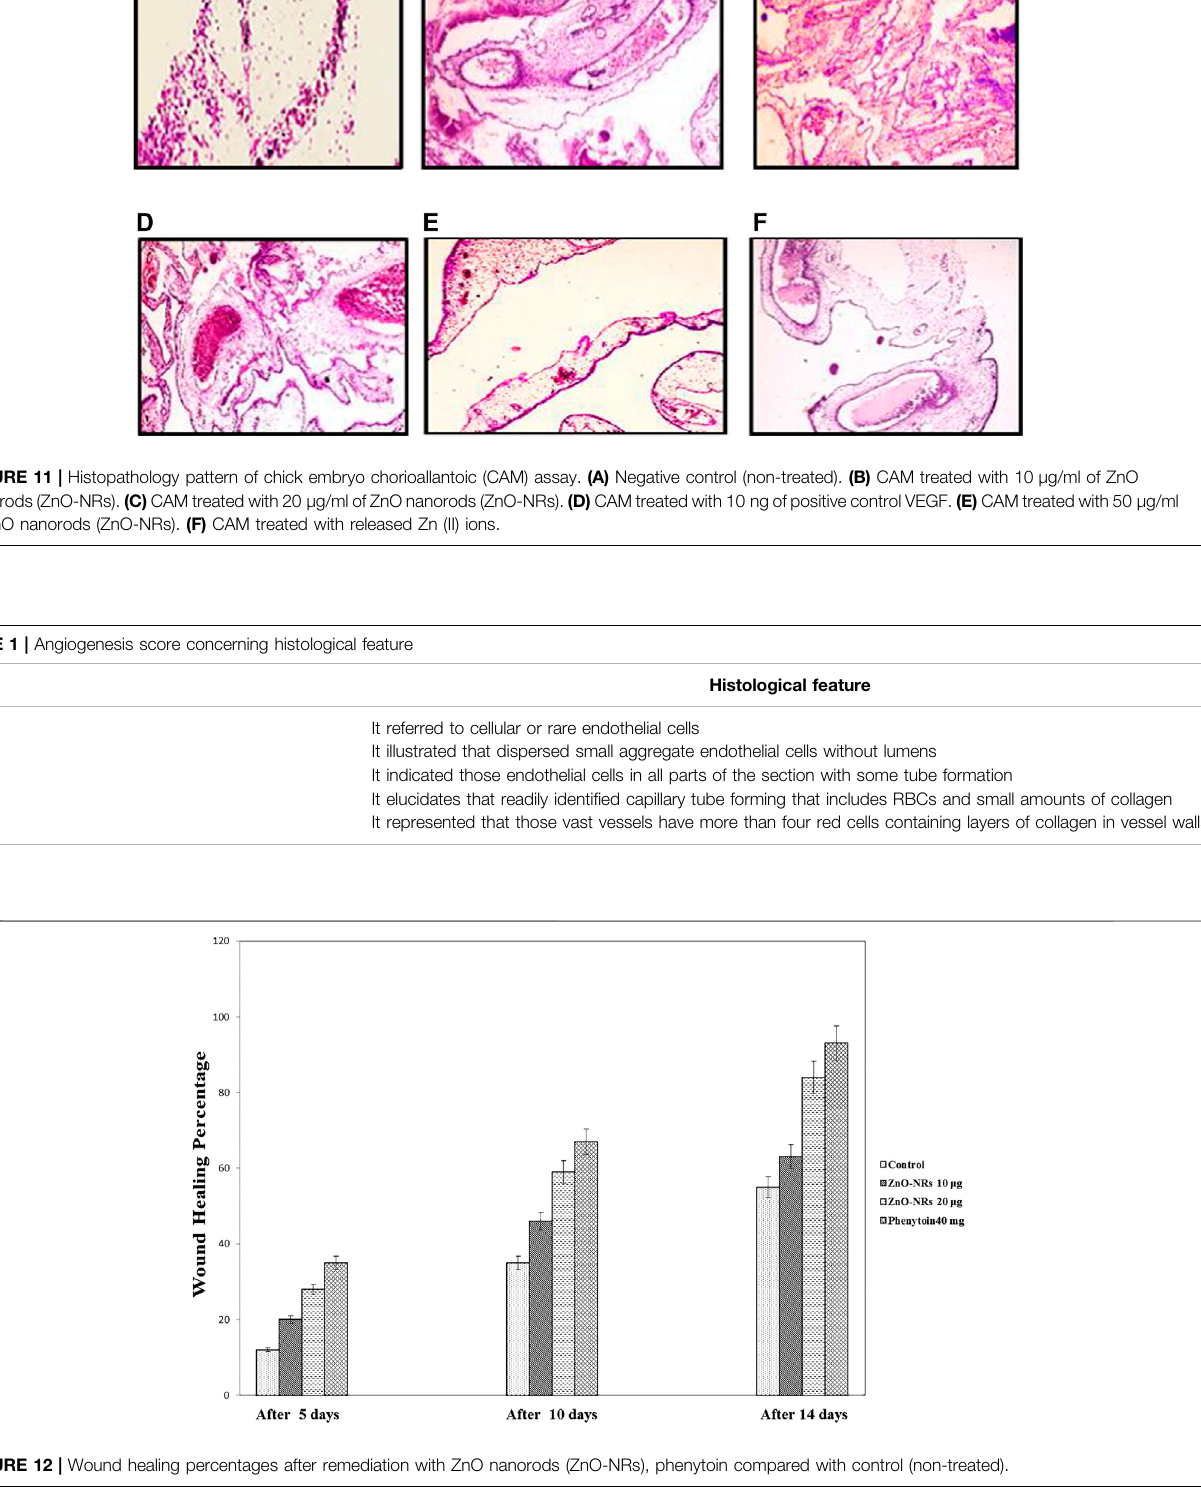
Frontiers in Pharmacology |